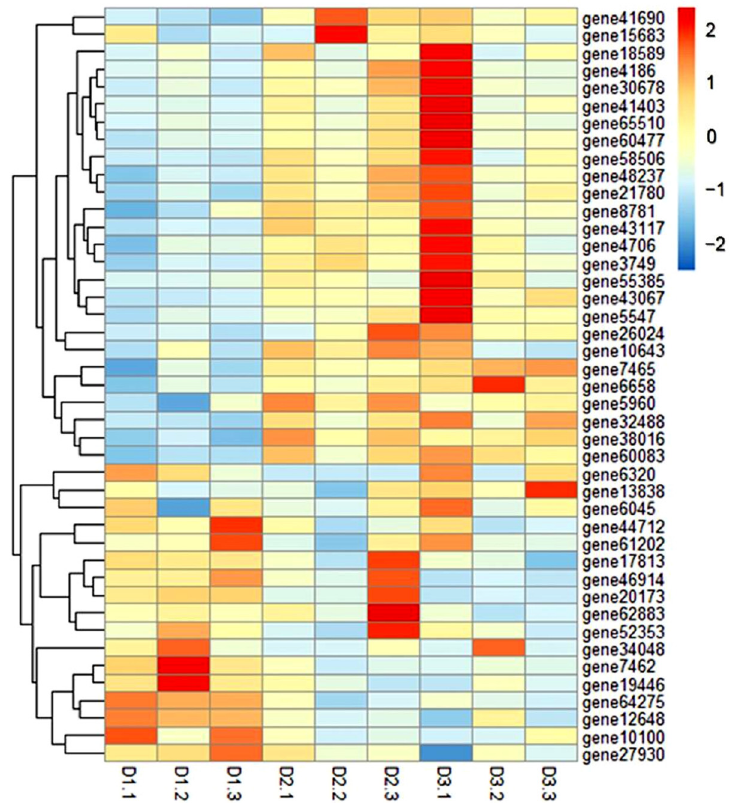
Figure 3. Clustered heat map of the expression of genes related to FoxO signaling pathways in common carp fed with diets D1–D3. The distance algorithm (inter-sample Spearman and inter-gene Pearson coefficients) was used for cluster analysis. Transcript enrichment is indicated in the heat map from low (blue) to high (red), as shown in the colored groups to the right of the heat map.